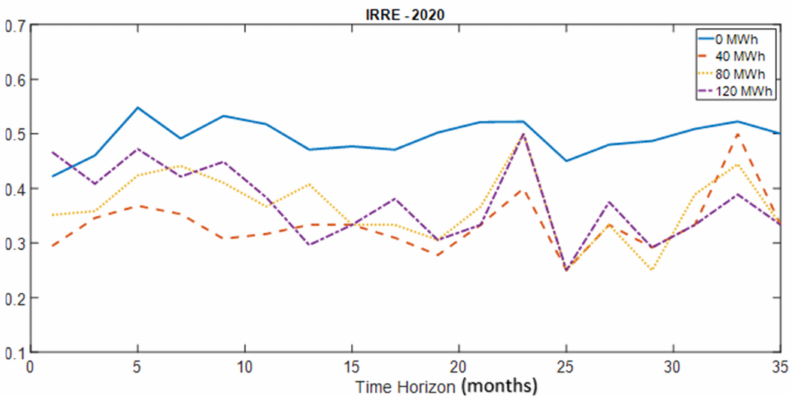
Figure 6. IRRE when a BESS is installed for 2020.